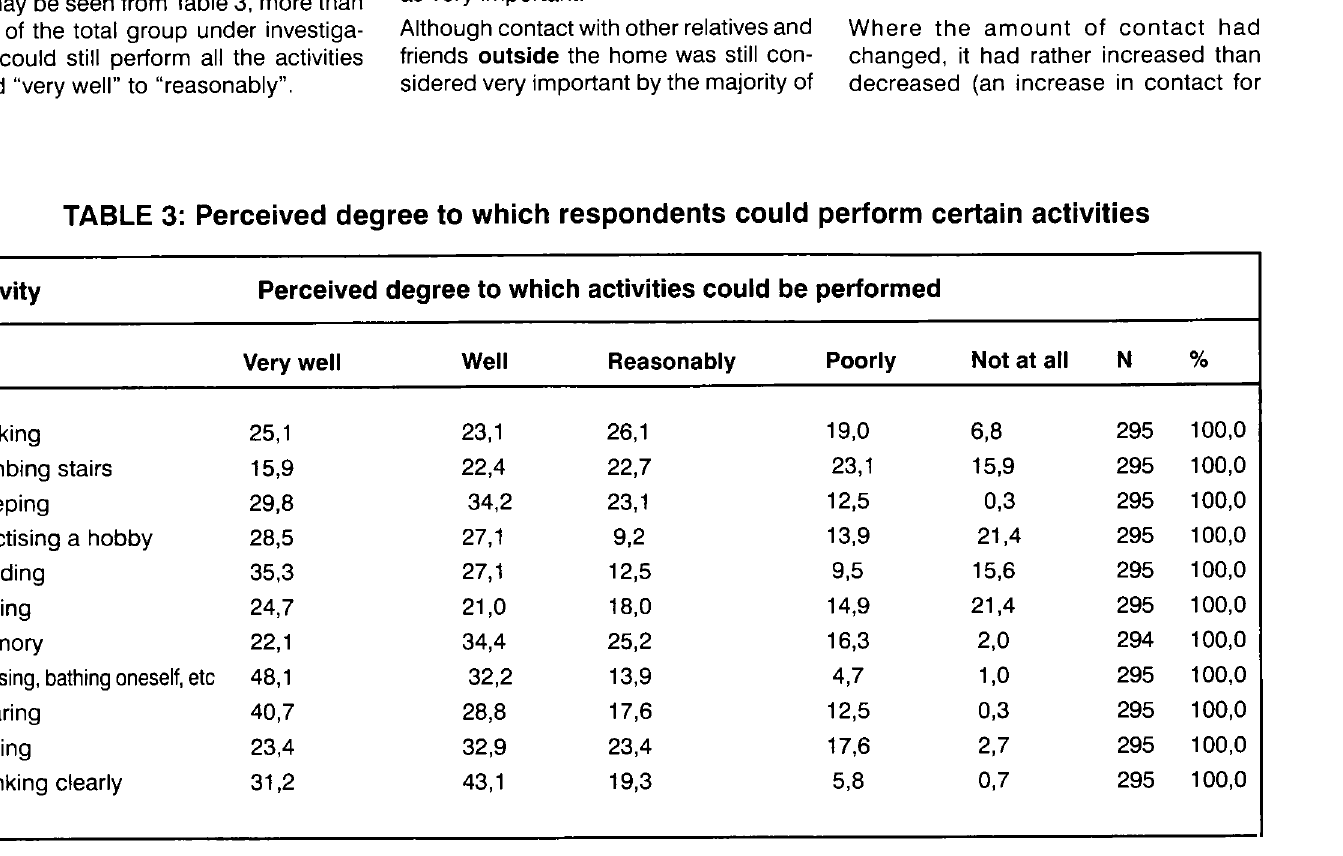
TABLE 3: Perceived degree to which respondents could perform certain activities